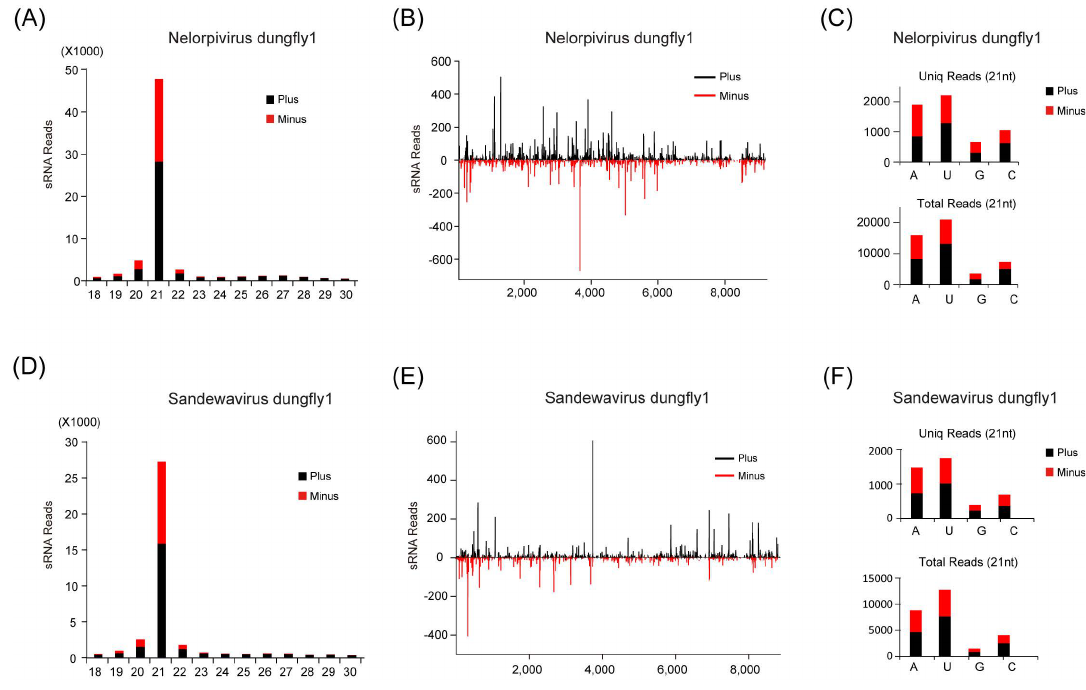
Figure 2. Profiles of virus-derived small interfering RNAs (vsiRNAs) of Nelorpivirus dungfly1 (NVD1) and Sandewavirus dungfly1 (SVD1). ( A ) Size distribution of NVD1 sRNAs. ( B ) Distribution of NVD1-derived sRNA along the corresponding viral genome. ( C ) 5 (cid:48) terminal nucleotide preference of sRNAs 21 nt long derived from NVD1. ( D ) Size distribution of SVD1 sRNAs. ( E ) Distribution of SVD1 derived sRNA along the corresponding viral genome. ( F ) 5 (cid:48) terminal nucleotide preference of sRNAs 21 nt long derived from SVD1. Color coding indicates viral sRNAs derived, respectively, from the sense (plus) and antisense (minus) genomic